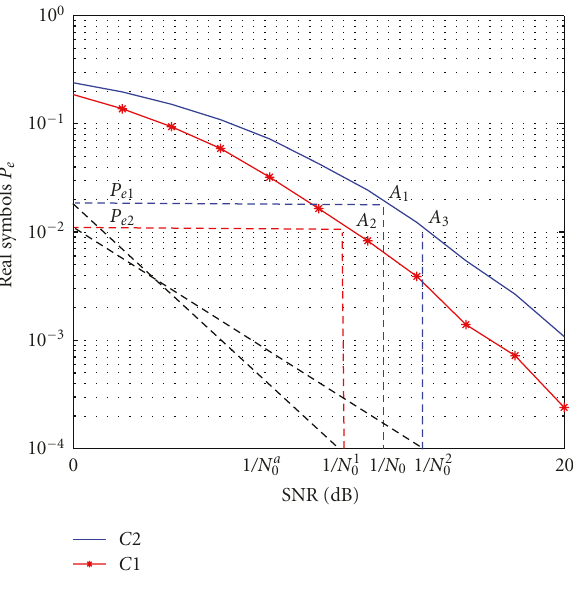
Figure 4: Convergence